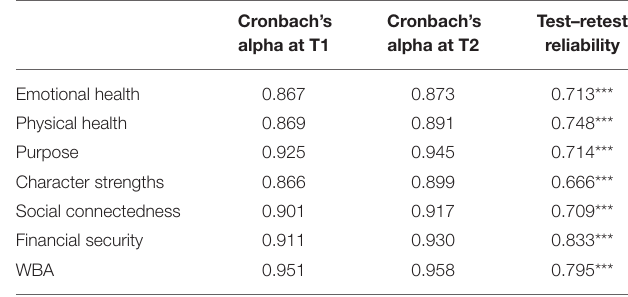
TABLE 7 | Reliability—Cronbach’s alpha and test–retest